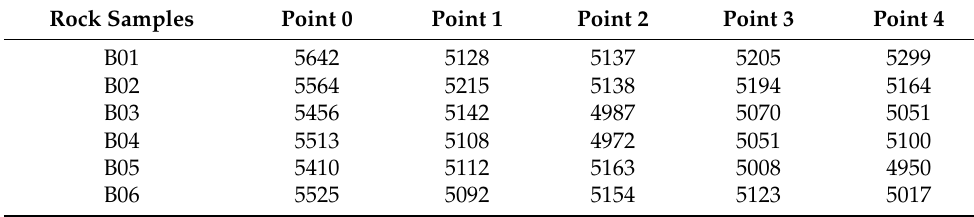
Table 4. Initial wave velocity at each point of rock sample (m · s − 1 ). Rock